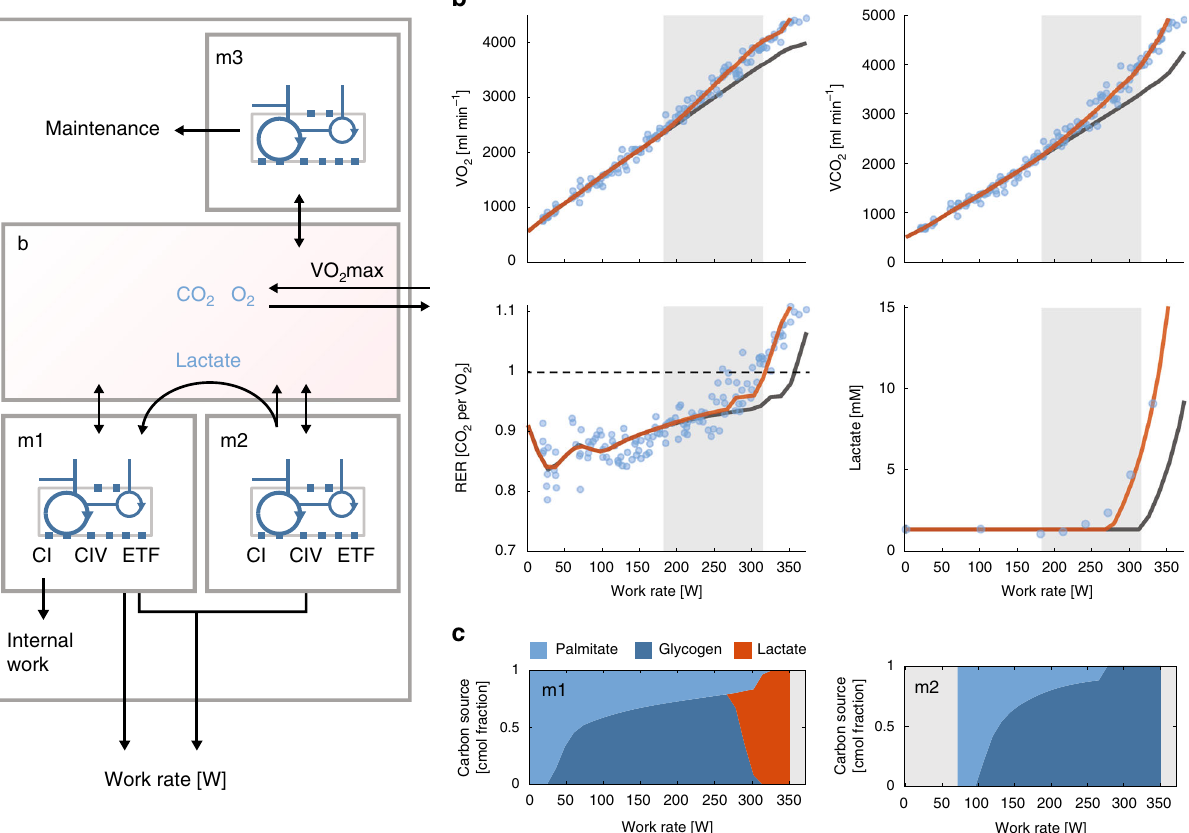
Fig. 4 The effects of complex I bypass in a multi-tissue model. a Schematic representation of the multi-tissue model. Three genome-scale models corresponding to muscle fi bers with high mitochondrial content (type I fi bers, m1), intermediary mitochondrial content (type II fi bers, m2), and peripheral tissues (m3) were joined by a shared extracellular compartment (b) resembling transport through the blood stream. The fl ux through ETF, CI, and CIV was constrained in m1 and m2, and scaled by a constant to allow for differences in enzyme concentrations between subjects. b It was possible to fi t the model (orange line) to experimentally observed VO 2 and VCO 2 data (blue circles) from a subject performing incremental exercise on a bike. The lactate concentrations in blood, which was obtained for the same subject at a different occasion, could also be fi tted assuming a Michaelis – Menten relation between the concentration and the predicted lactate fl ux. The fi t for the model with complex I bypass was better than for a model without (gray line). The oxygen expenditure was highest in a region (indicated with gray shading) between complex I bypass and before lactate accumulation, as given by RER > 1 (dashed line). c Relative substrate utilization in the two muscle fi ber sub-models (cmol) showed a shift from fatty acids as carbon source towards glycogen. After complex IV was saturated in m2 the model predicted a fl ux of lactate from m2 to m1